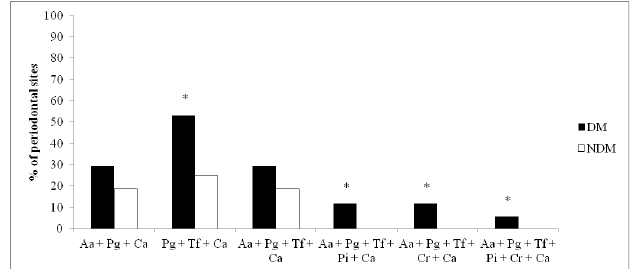
Fig. 2 - Frequency of periodontal sites (%) harboring combinations of putative periodontopathogens with Candida albicans (Ca) in the DM and NDM groups. *Statistically significant differences between the DM and NDM groups, according to χ2 tests (p <0.05). Aggregatibacter actinomycetemcomitans (Aa), Porphyromonas gingivalis (Pg), Tannerella forsythia (Tf), Prevotella intermedia, Campylobacter rectus (Cr).